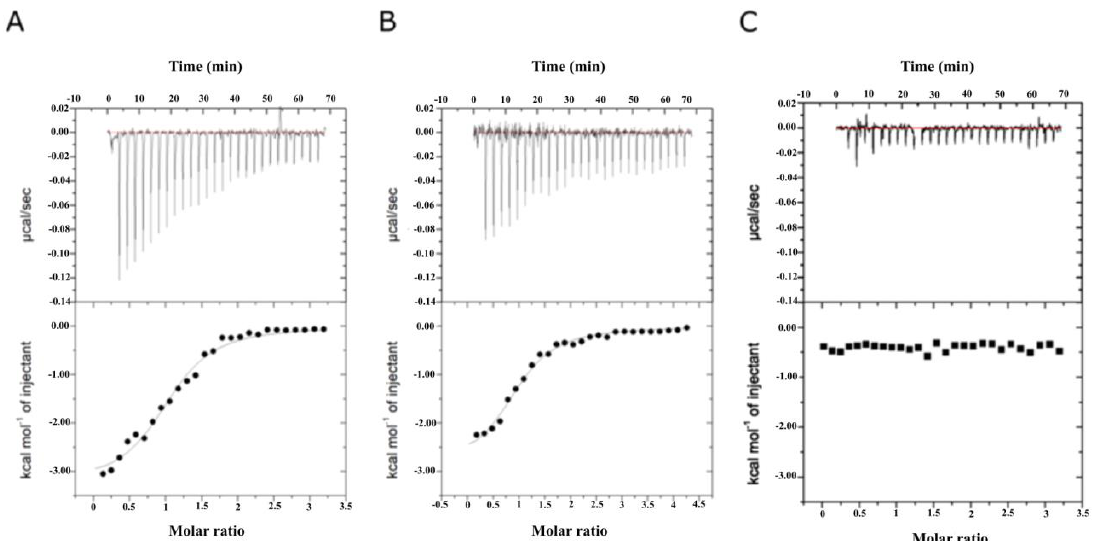
Figure 3. ITC binding studies of Gal-3 CRD and Gal-9N CRD with SeDG-Bn. Titration of ( A ) Gal-3 CRD and ( B ) Gal-9N CRD with SeDG-Bn. Titration of ( C ) buffer with SeDG-Bn (negative control). The top panels of the graphs correspond to the injections, while the bottom panels correspond to the integrations of the peaks according to the molar ratio of the tested molecules.